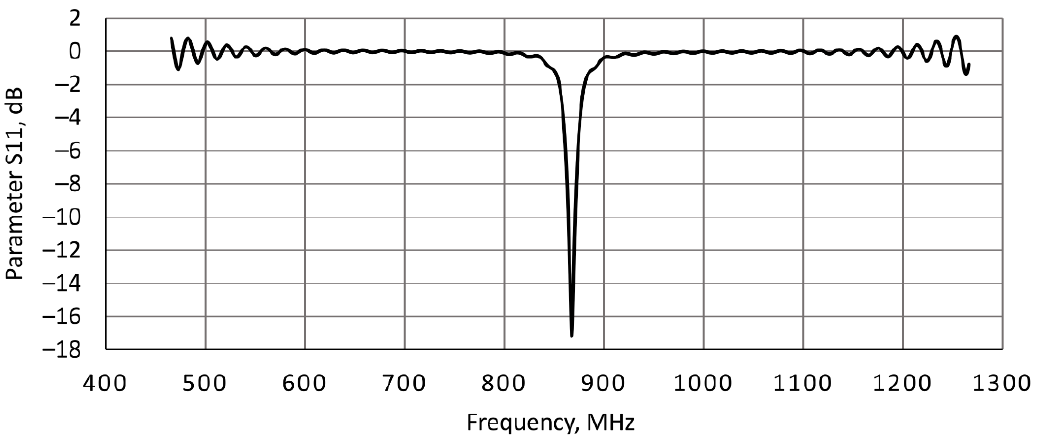
Figure 3. The S11 parameter determined using numerical simulations of the developed numerical model of the rectangular microstrip patch antenna used in the UHF RFID readers.